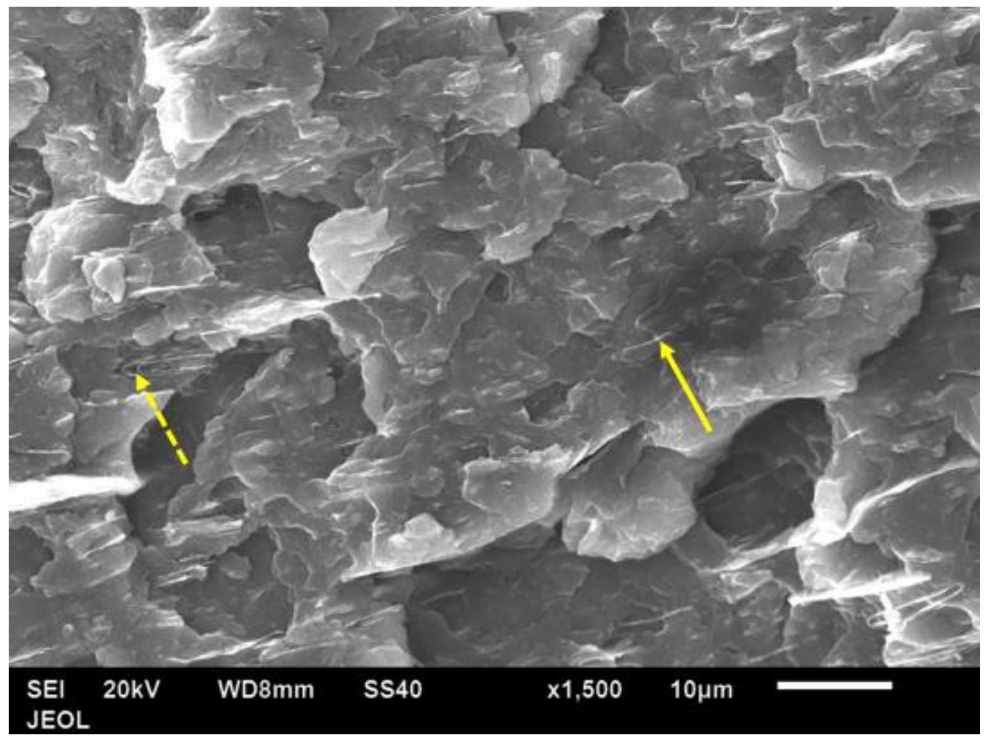
Figure 18. SEM image of a fracture cross-section of a 15 vol.% Al platelet–amorphous PET composite. The platelets are seen only edge-on (arrow). The dotted arrow shows two platelets that have folded back on themselves.